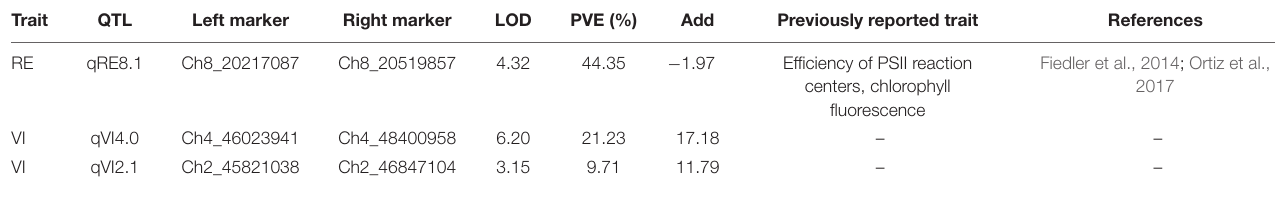
TABLE 5 | Quantitative trait loci (QTLs) detected for the recovery (RE) and visual injury 3 weeks after treatment (VI) along with logarithm of the odds (LOD) and phenotypic variation explained (PVE) explained by QTLs. Trait QTL Left